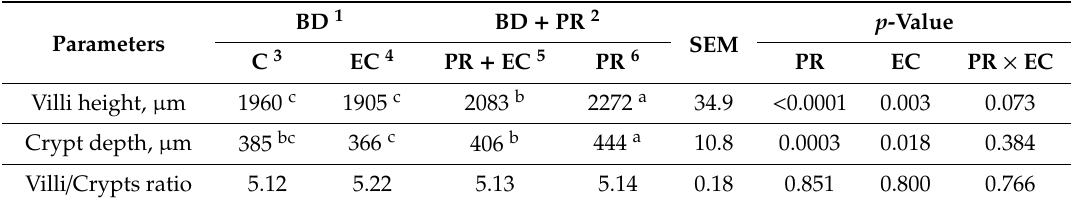
Table 4. The e ff ects of dietary propolis supplementation and E. coli challenge on histomorphological measurements of small intestines in laying hens ( n = 5).